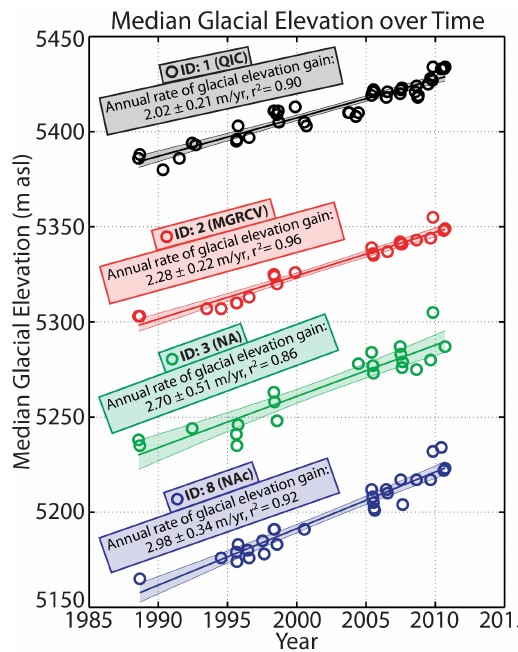
Fig. 14. Median glacial elevation ( ± 95% CI) against the time se- ries of this study for the four largest glacierized IDs in this region (IDs 1: Quelccaya Ice Cap (QIC), 2: main glacierized region of the CV (MGRCV), 3: Nevado Ausangate region (NA), and 8: Nevado Allincapac region (NAc), a glacierized area just beyond the eastern boundary of the CV).